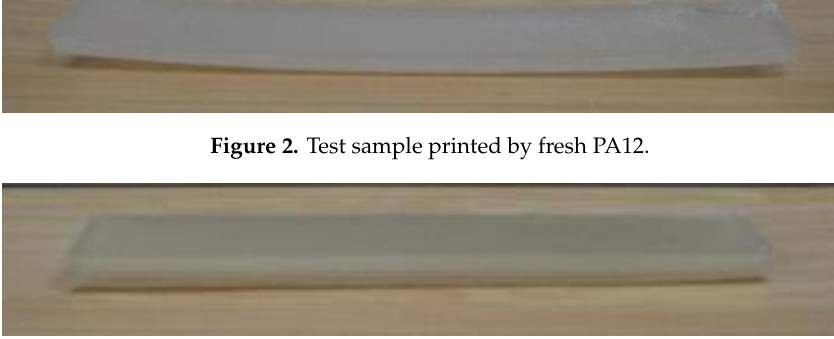
Figure 3. Test sample printed by recycled PA12.